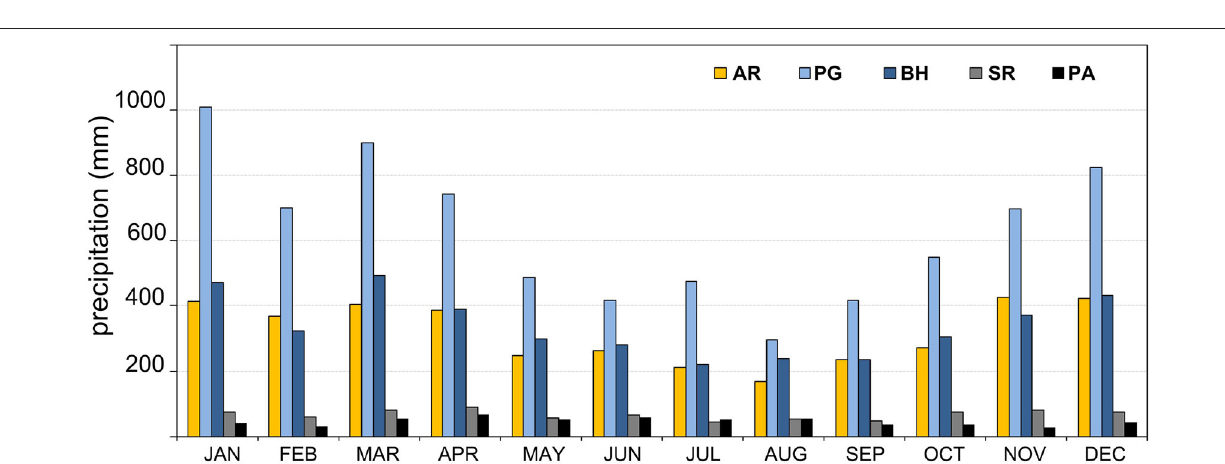
amount of ~9,500 mm measured in 2003. Higher